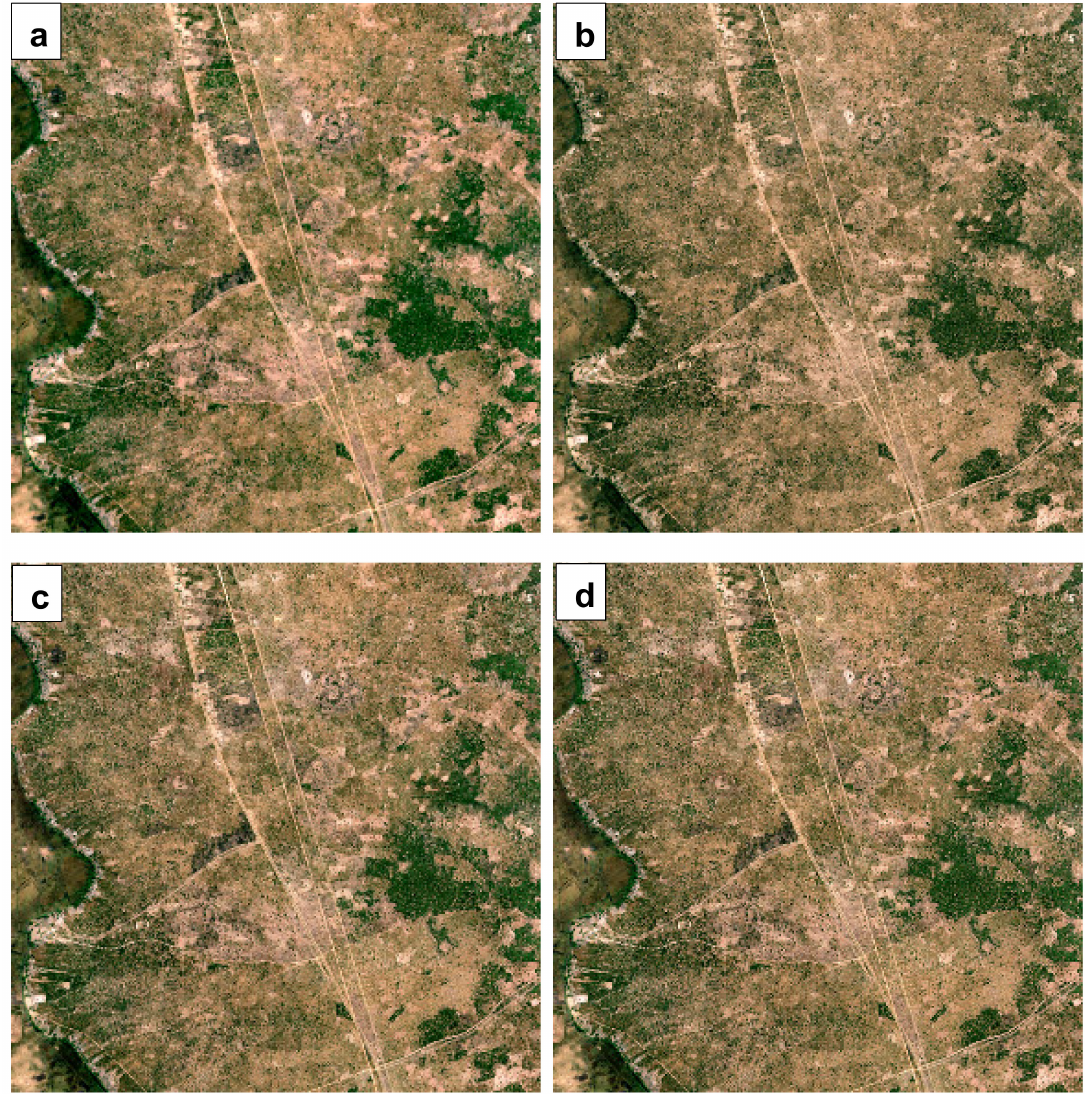
Figure 2. Study site 2 true color surface reflectance images, composed of 1800 × 1800 3.333 m pixels covering 6 × 6 km ( a ) Sentinel-2 reflectance bilinear resampled from 10 m, ( b ) Planetscope reflectance, ( c ) Sentinel-2 HPM sharpened from 10 m, and ( d ) Sentinel-2 M3 sharpened from 10 m. Images